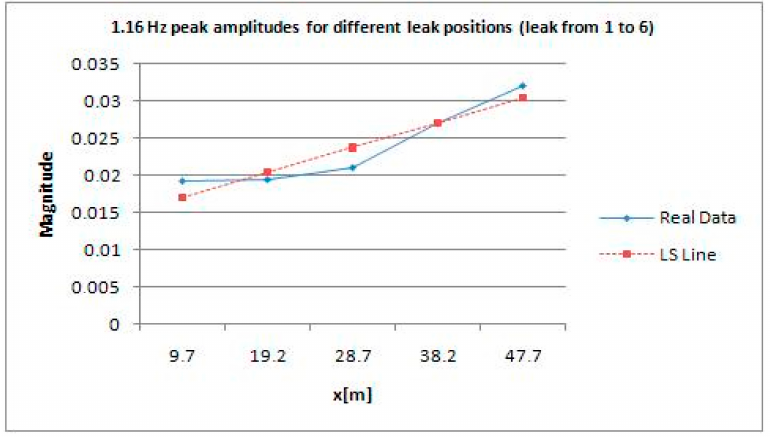
Figure 13. Example of linear regression implementation for retrieving leak position (leak from 1 to 6).